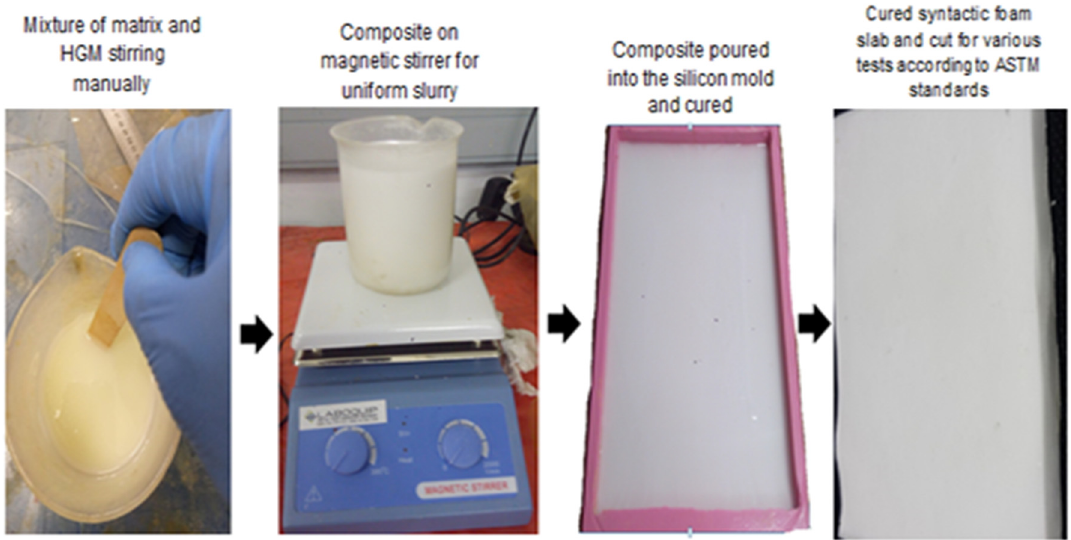
Figure 2. Processing sequence of syntactic foam composite showing different stages involved.